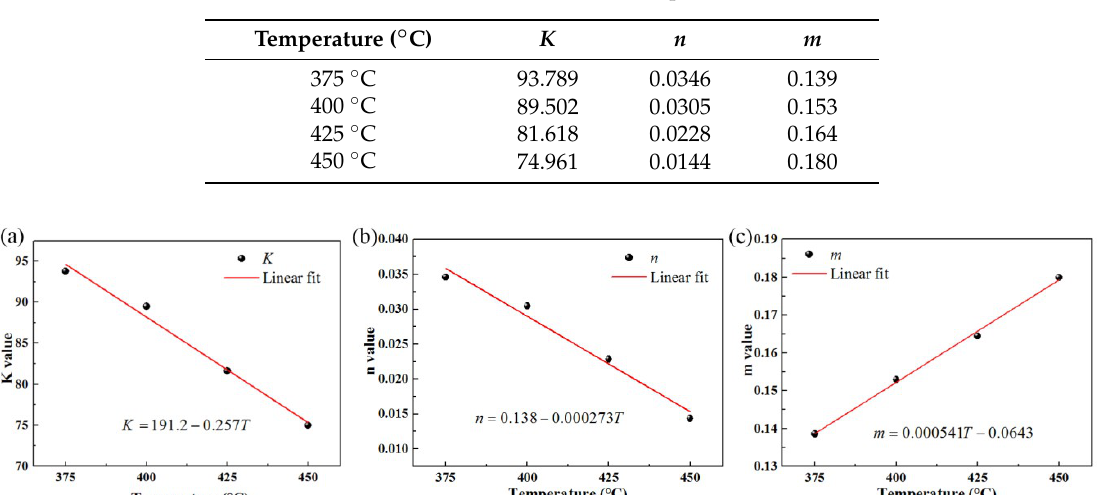
Table 2. Parameters at different temperatures.